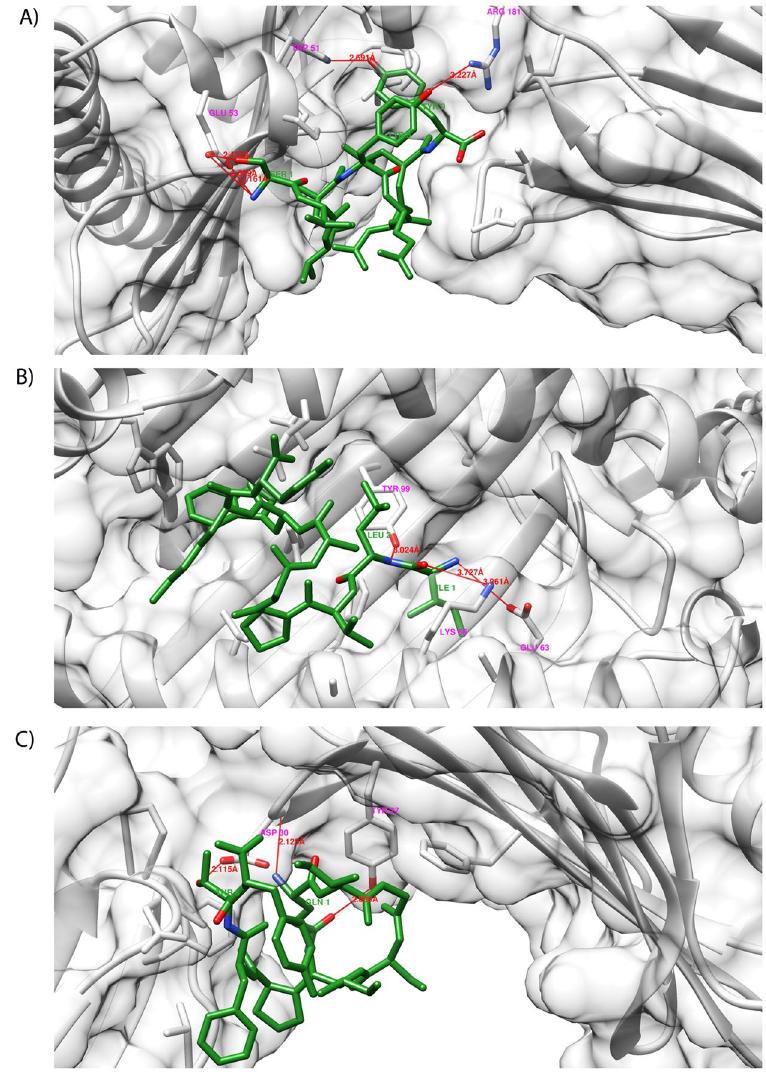
Figure 4. Molecular interaction analysis of predicted CTL epitopes docked to MHC-I molecule. ( A ) STVAYEDLY-HLA-A * 0201 docking complex interacting with five hydrogen bonds; ( B ) ILVPGAWKY- HLA-A * 0201 complex interacting with three hydrogen bond; ( C ) QIGSIPFTY-HLA-A * 0201 complex making three hydrogen bonds. The residues forming H-bonds are labelled in magenta and green colour for HLA protein and epitope respectively. Each residue participating in H-bonding are coloured with Atom type (Red: Oxygen, Blue: